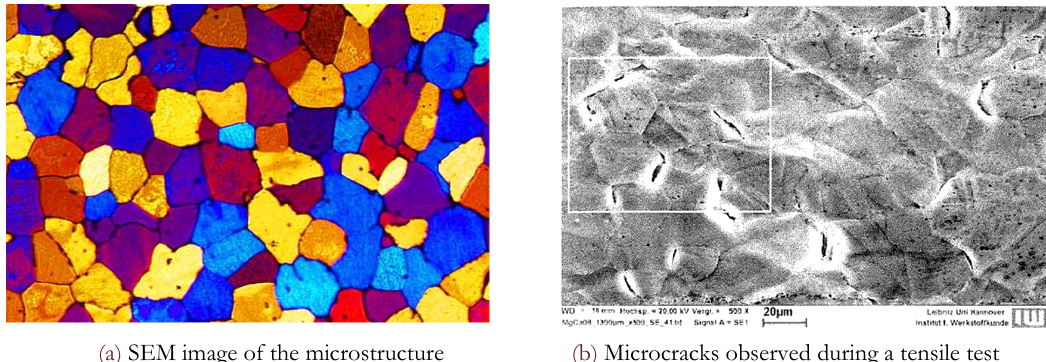
Figure 1: SEM images of brittle polycrystalline materials showing microcracks (courtesy of Dr. Ing. M. Schaper